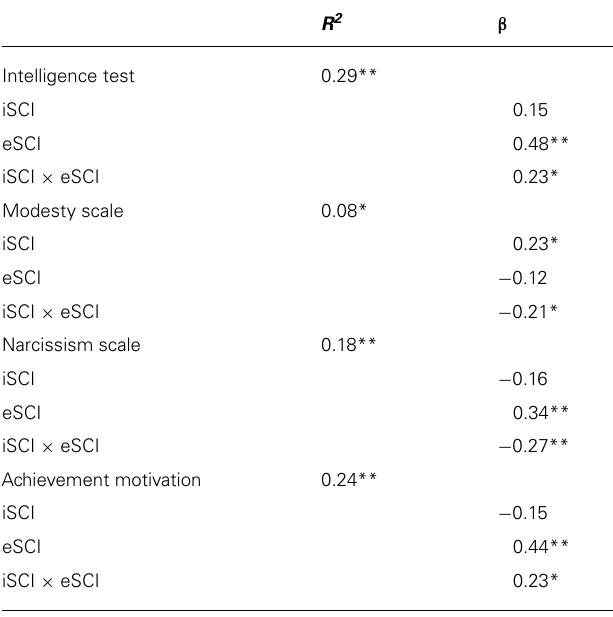
Table 2 | Regression analyses predicting intelligence test performance, modesty, narcissism, and achievement